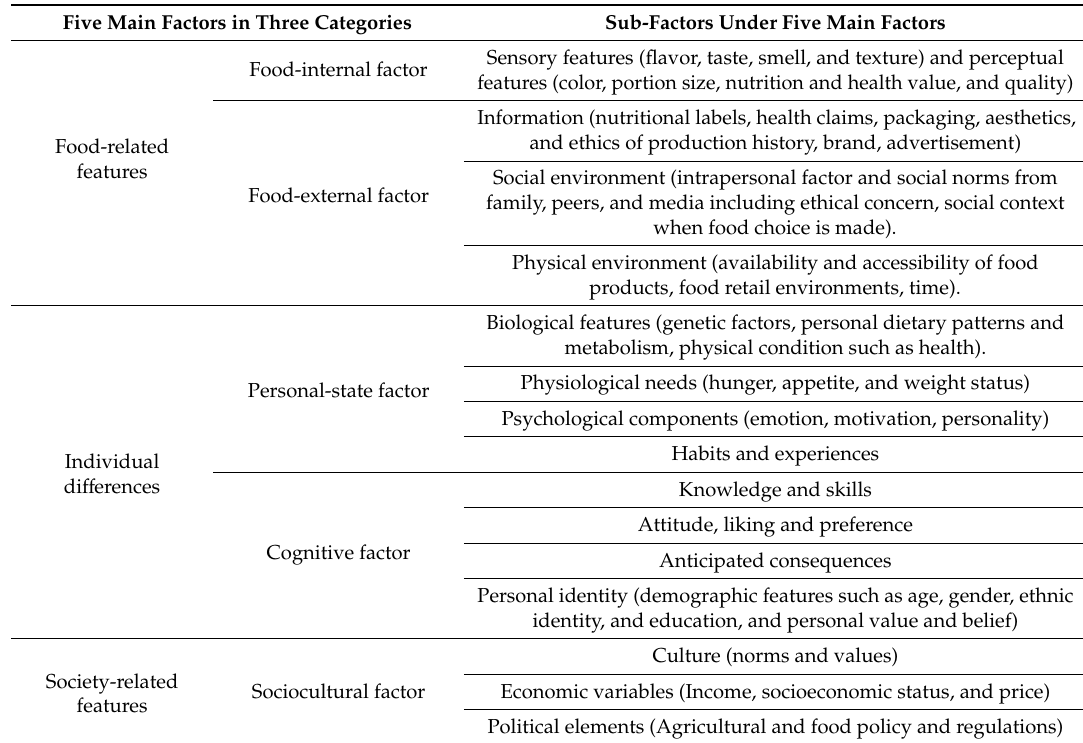
Table 1. Factors influencing individual food choice included in our proposed